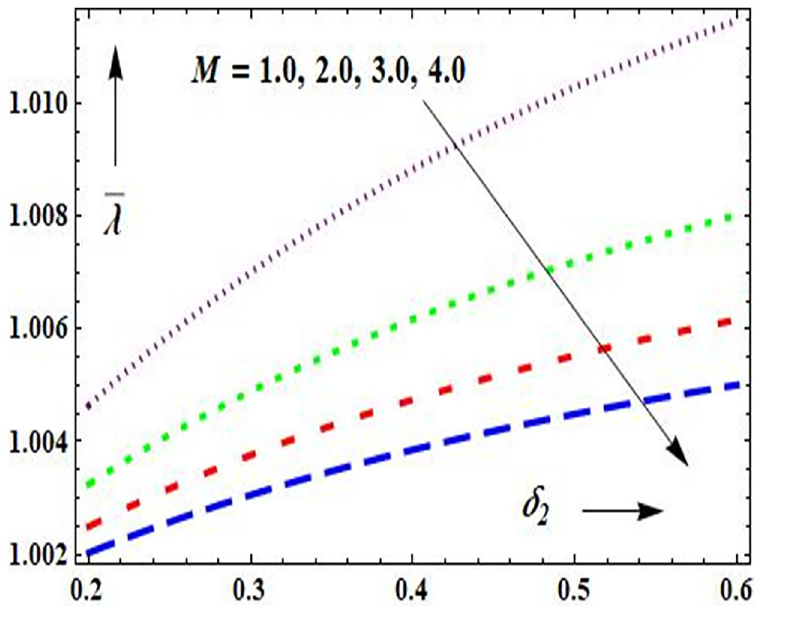
Fig 5. Plot of � λ on M & δ 2 with ϕ ¼ π